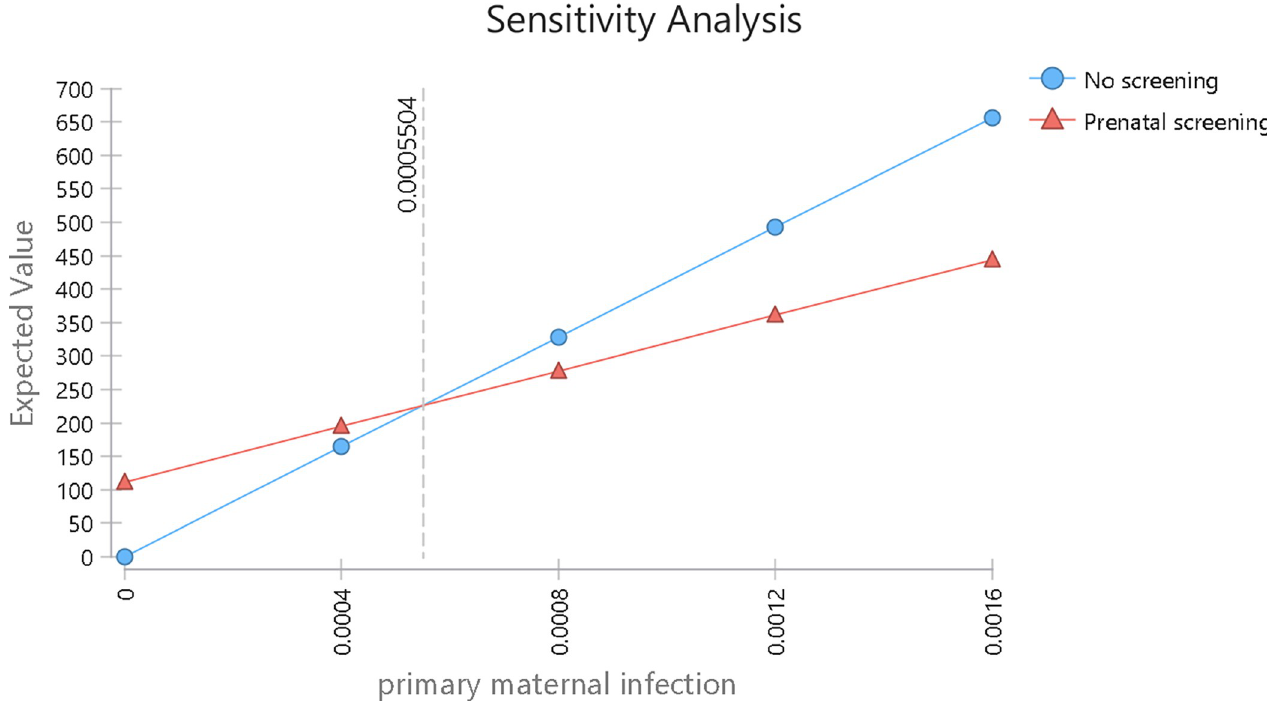
Fig 2. Sensitivity analysis of the expected value of prenatal screening for toxoplasmosis vs no screening, according to the annual incidence of primary maternal infection.